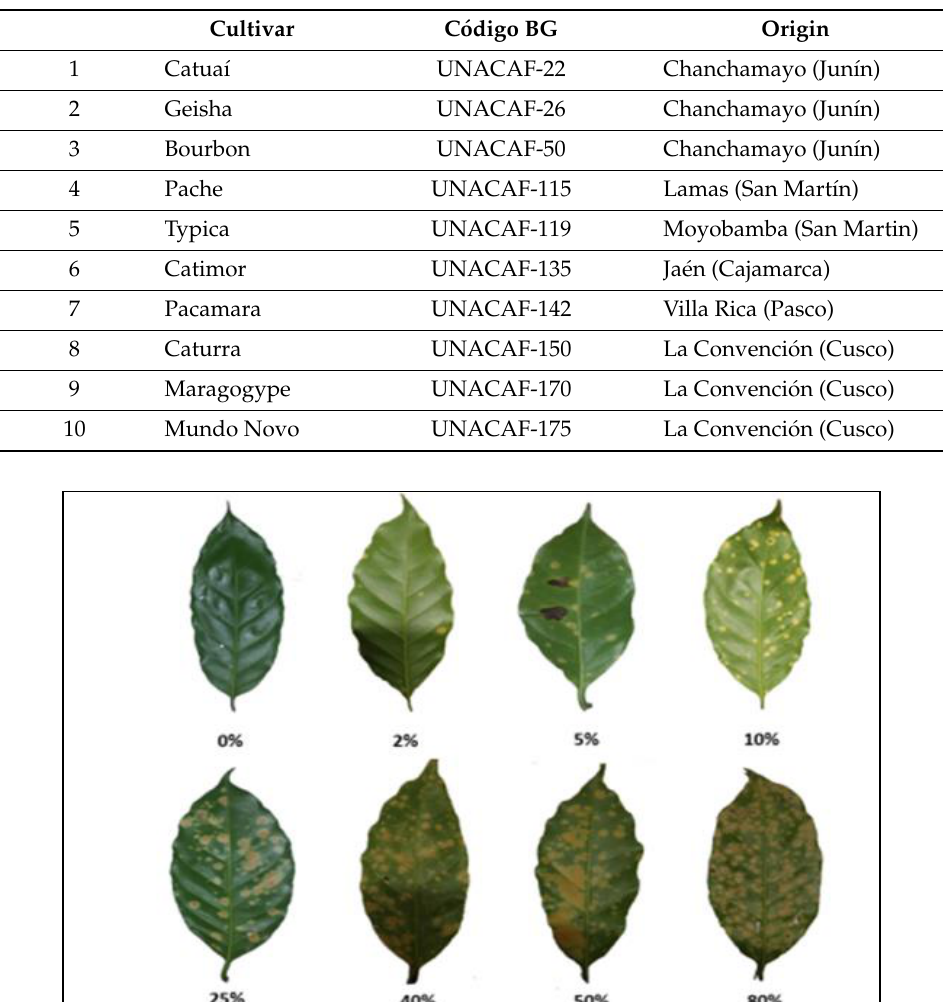
Table 1. Coffee cultivars studied in this evaluation and collection site in Peru [9].